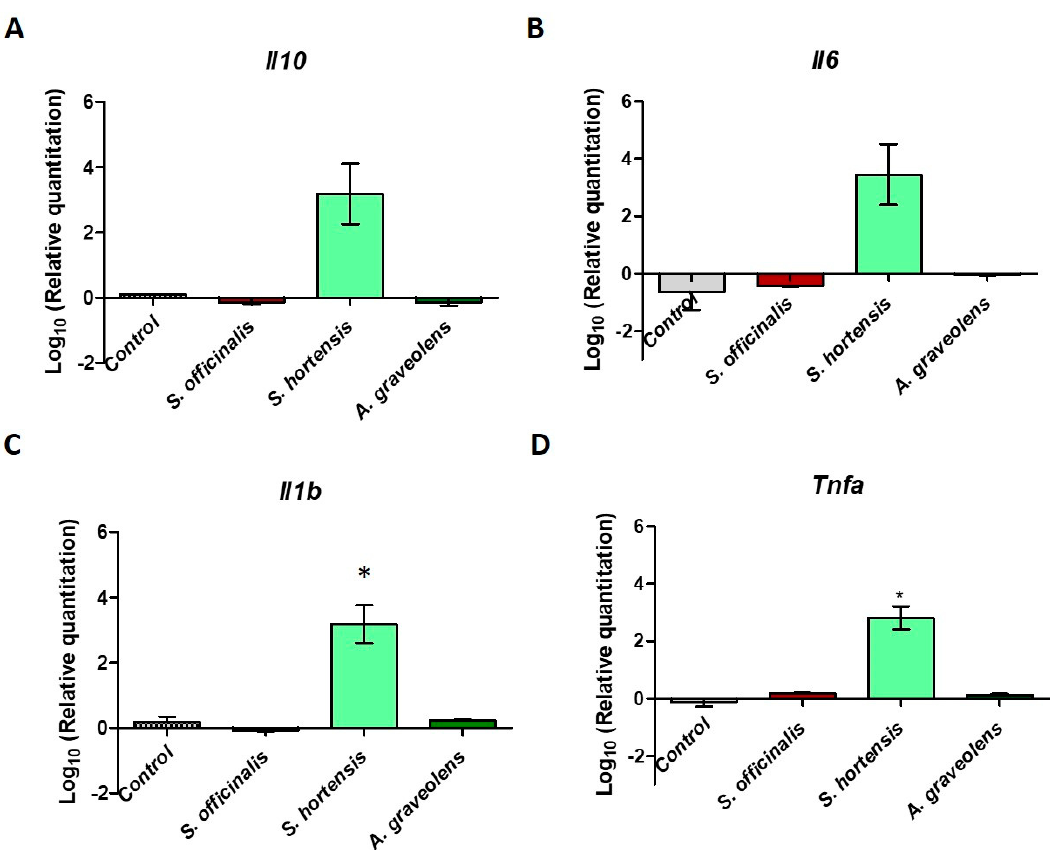
Figure 2. Cytokine expression in THP-1 cells treated with essential oils (EOs) extracted from Salvia officinalis (sage), Satureja hortensis (summer savory), and Anethum graveolens (dill). n = 3 ( t -test) and control—unstimulated cells. ( A ): expression of IL-10; ( B ): expression of IL-6; ( C ): expression of IL-1 β ; ( D ): expression of TNF- α . *, significant di ff erence p <